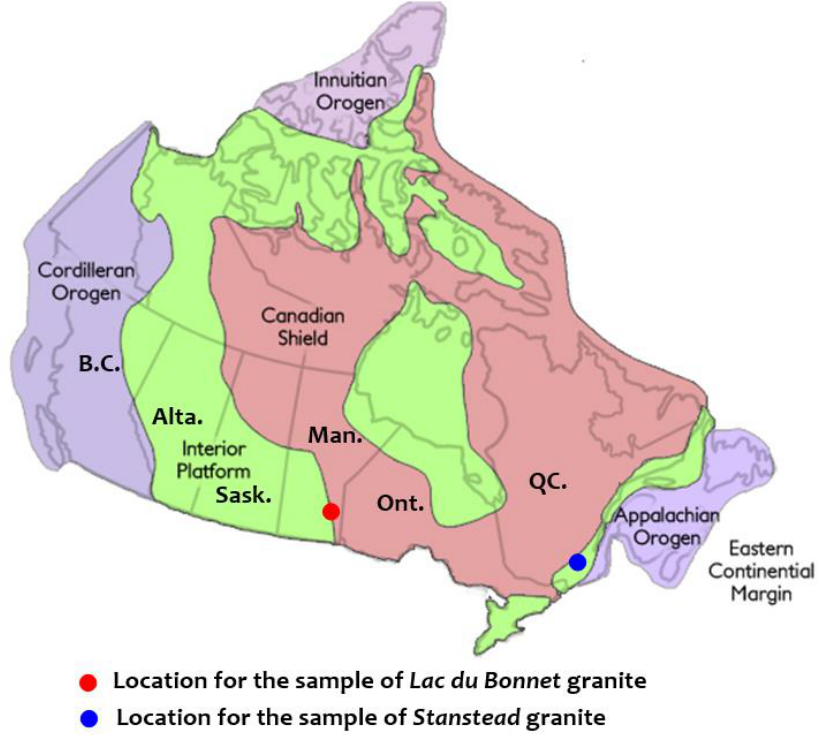
Figure 1. The outcrop of the Canadian Shield [1].